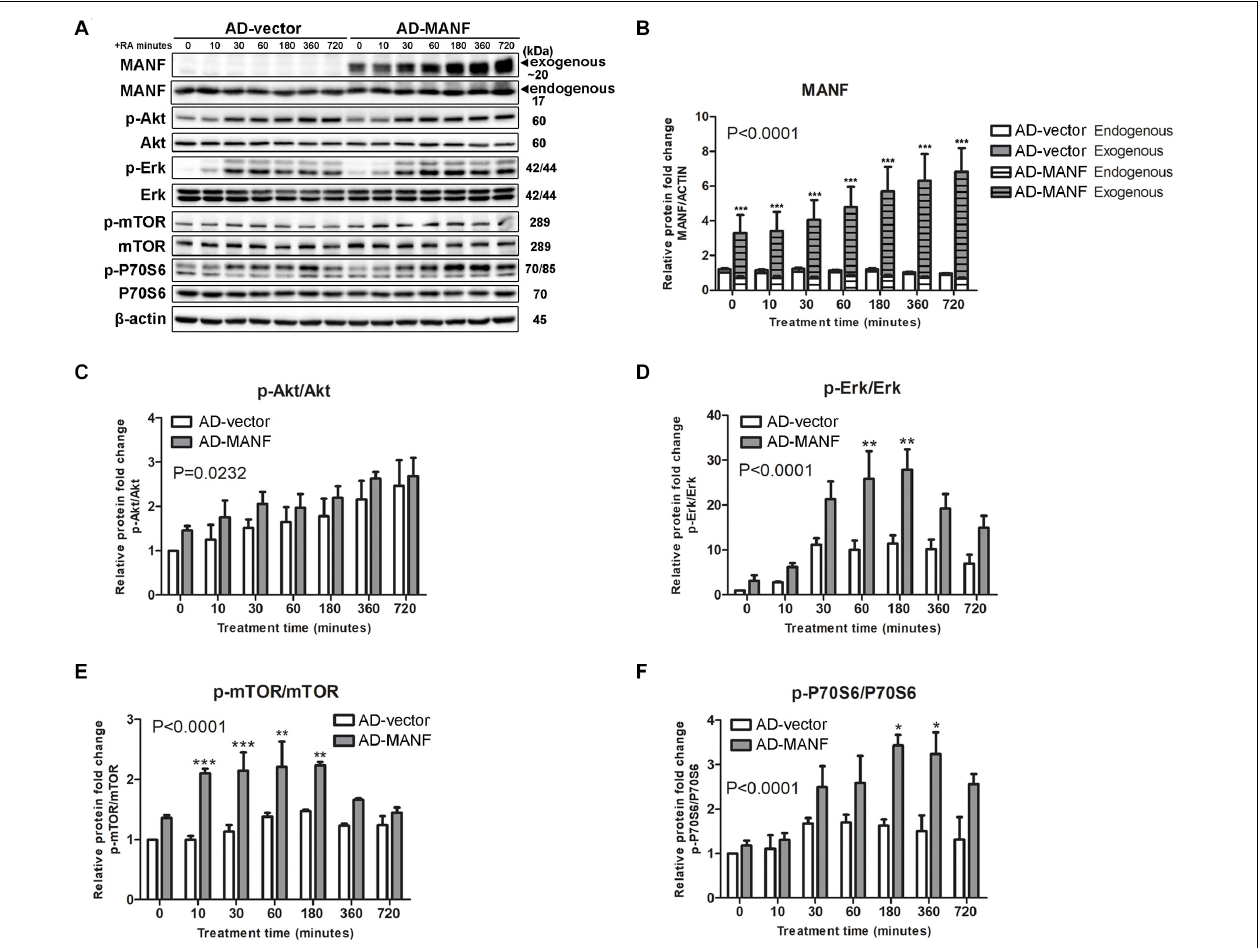
FIGURE 7 | MANF overexpression enhances RA-induced activation of Akt/mTOR and Erk/mTOR signaling pathways. (A) AD-vector and AD-MANF transduced cells were treated with RA for 10, 30, 60, 180, 360, and 720 min. Protein was extracted from cell lysates and subjected to immunoblot. The size of the proteins (kDa) was labeled next to each band. (B) Endogenous and exogenous MANF protein levels were quantified and normalized with β -actin. (C) p-Akt protein levels were quantified and normalized with total Akt. (D) p-Erk protein levels were quantified and normalized with total Erk. (E) p-mTOR protein levels were quantified and normalized with total mTOR. (F) Quantification of p-P70S6 protein levels were quantified and normalized with total P70S6. The data were expressed as the mean ± SEM of three independent experiments and were analyzed by Two-way ANOVA followed with the Bonferroni’s post hoc test, * P < 0.05, ** P < 0.01, *** P <